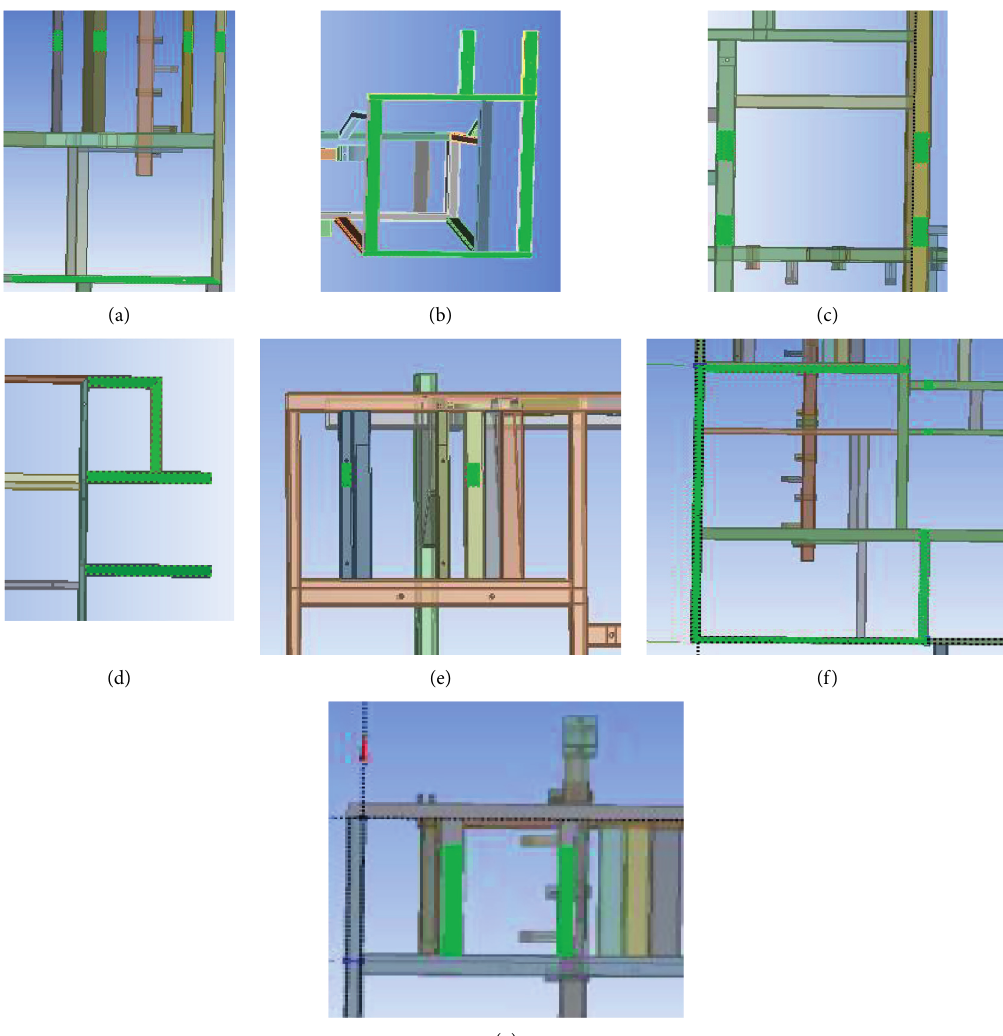
Figure 7: Marking diagram of the force parts of the main components of the track walking chassis. (a) Grain box bearing load mark diagram. (b) Cab bearing load mark diagram. (c) Engine bearing load mark diagram. (d) Oil tank bearing load mark diagram. (e) Cylinder bearing load mark diagram. (f) Threshing drum bearing load mark diagram. (g) Battery bearing load mark